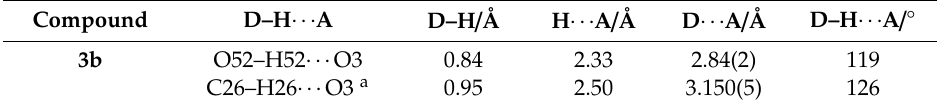
Figure 1. Structure of the asymmetric unit of 1b ( top ) and 3b ( bottom ). Please note that for 1b only a structural motive was obtained. For 3b , ellipsoids are drawn at a 50% probability level. Hydrogen atoms and disordered atoms were omitted for clarity. Table 3. Overview of the intermolecular interactions of 3b